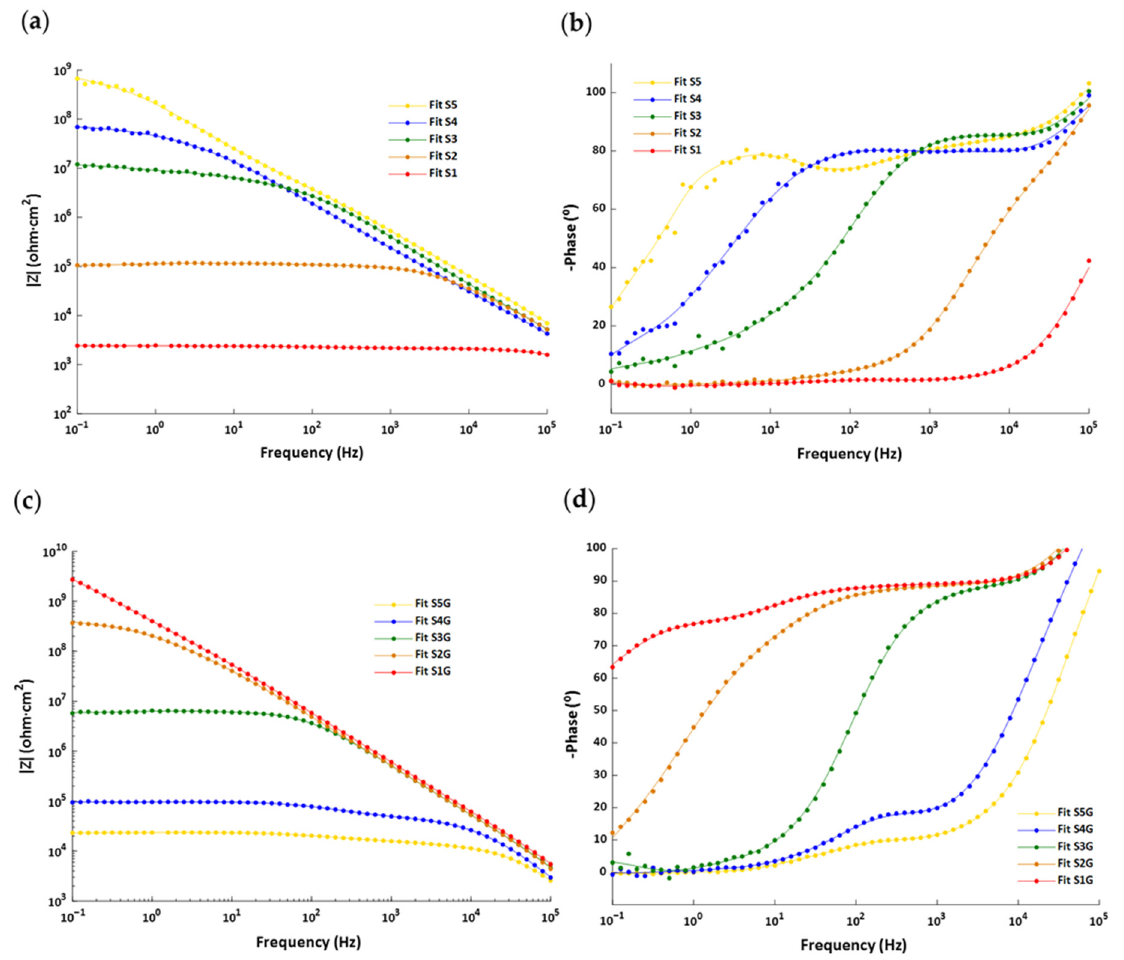
Figure 16. Bode diagrams corresponding to the S1–S5 samples: ( a ) modulus and ( b ) frequencies as well as those corre- sponding to the S1G–S5G samples: ( c ) modulus and ( d ) frequencies.